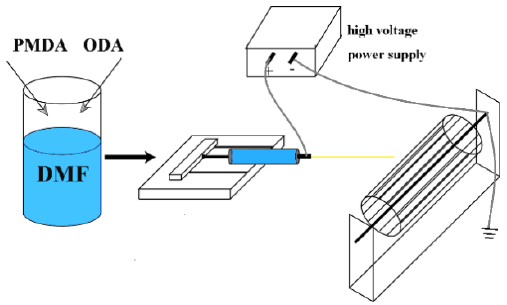
Figure 1. Synthesis of polyamic acid (PAA) solution and the process of electrospinning.